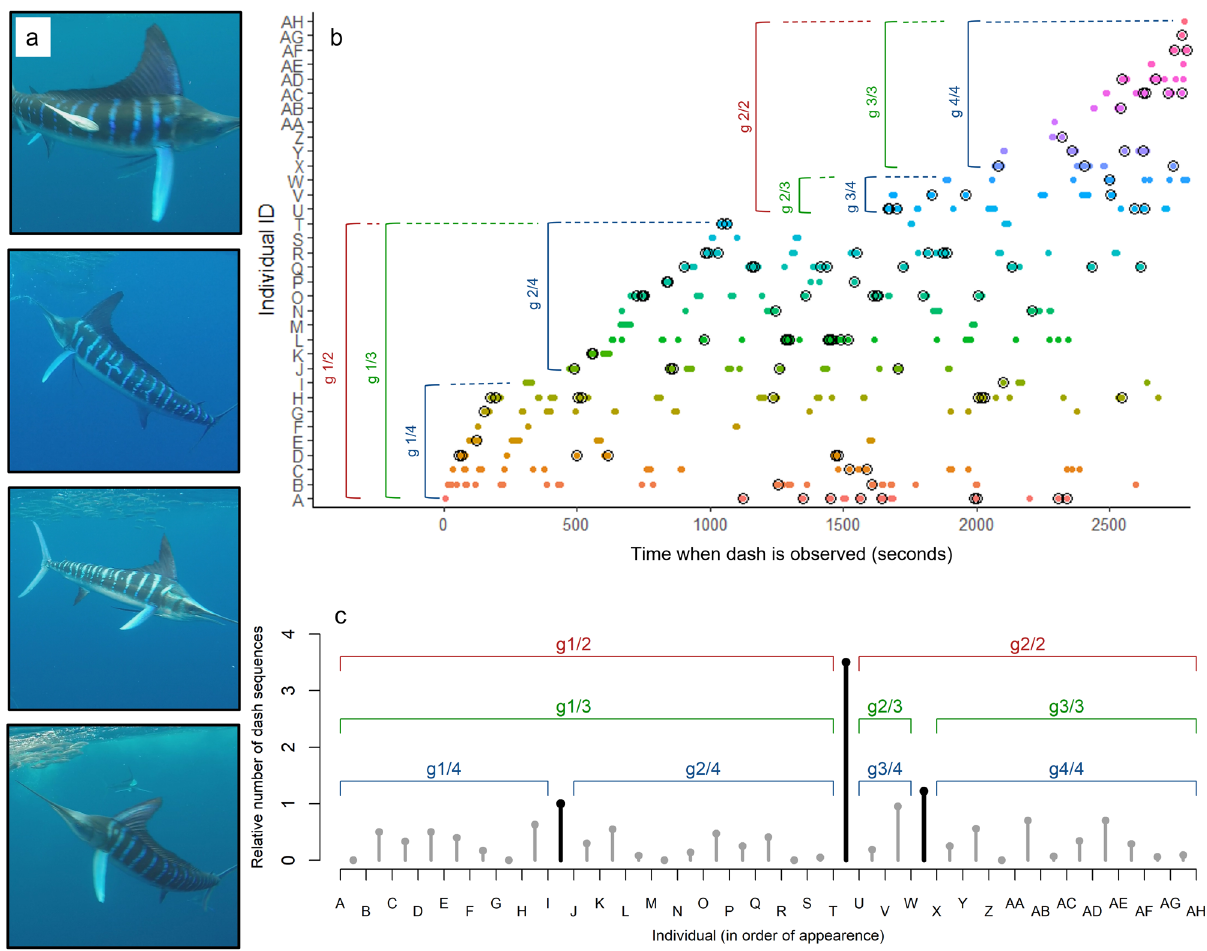
Fig. 1 Dashes and captures of individually identi fi ed striped marlin with potential sub-grouping. a Examples of unique markings used for individually identifying marlin (images created by Matthew Hansen). b Each dot shows the timing of a dash by an individual marlin in 2018. Marlin are colour coded to differentiate between individuals. Dashes that resulted in a prey capture are encircled ( ○ ). Groups arriving at different time points are bracketed in different colours, with three potential scenarios: marlin arriving in two groups ( ), three groups ( ), or four groups ( ). c The three potential sets of arriving groups of marlin in 2018 that can be derived from the numbers of dash sequences between the appearances of individual marlin, two groups ) or four groups ( ). Fig. S1 shows corresponding 2019